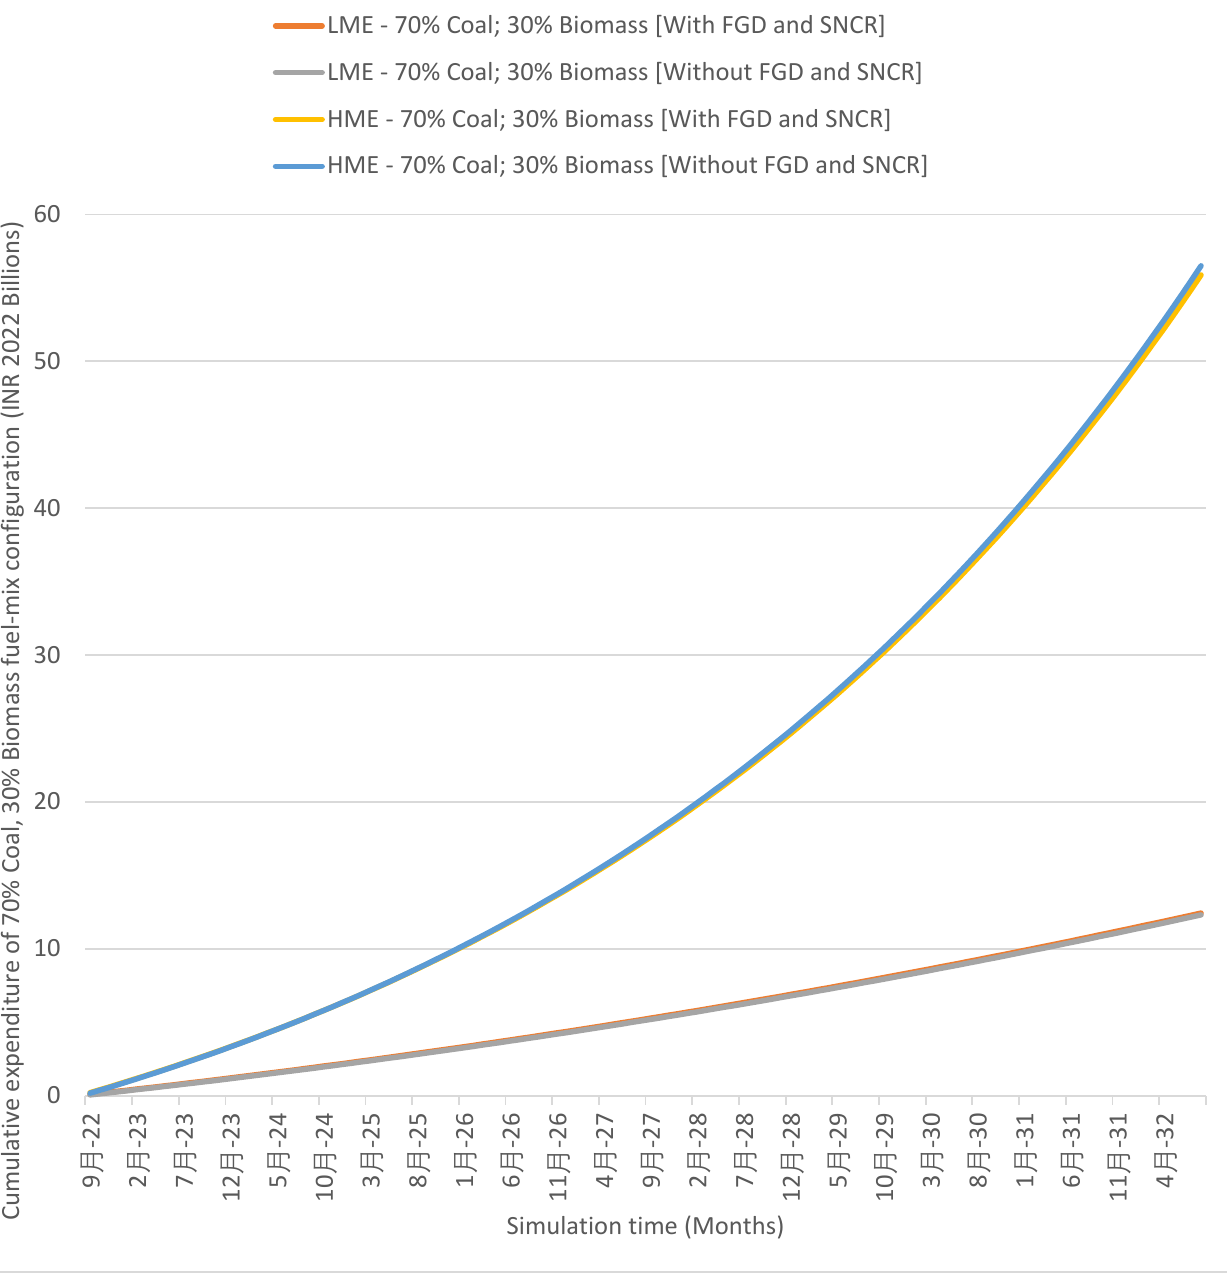
Figure 10. The effect of FGD and SNCR systems on the cumulative expenditure of fuel-mix configuration – 70% Coal, 30% Biomass under LME and HME scenarios. The amount of cumulative SOx emissions generated under each of the five fuel-mix configurations considered in this study is depicted in Figure 11. A combination of 70% Coal and 30% Biomass led to the least amount of SOx emissions among the configurations tested, which is 23.4% lower than using 100% coal.